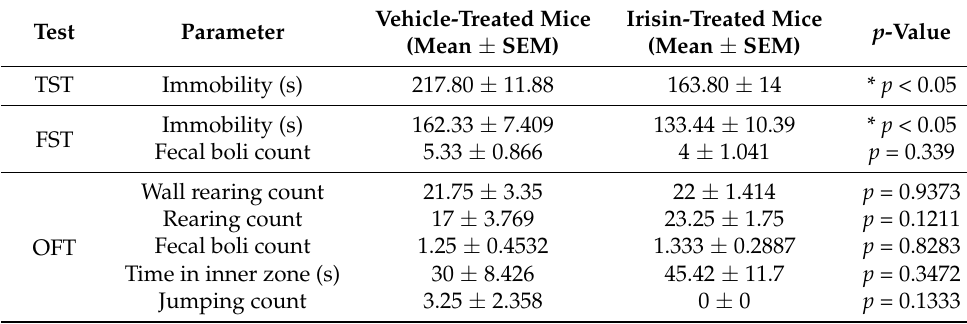
Table 1. Summary of behavioral test